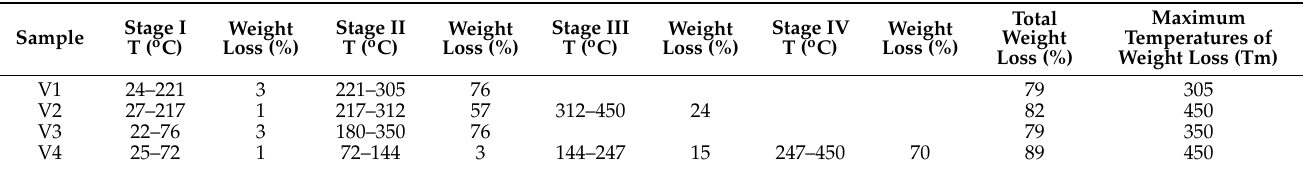
Table 3. Results of weight-loss ratios for the samples from the validation experiments.